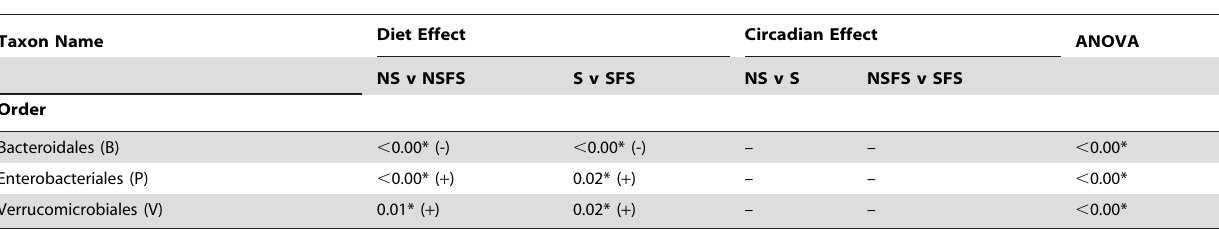
Table 3. Significant between group comparisons by taxon level.